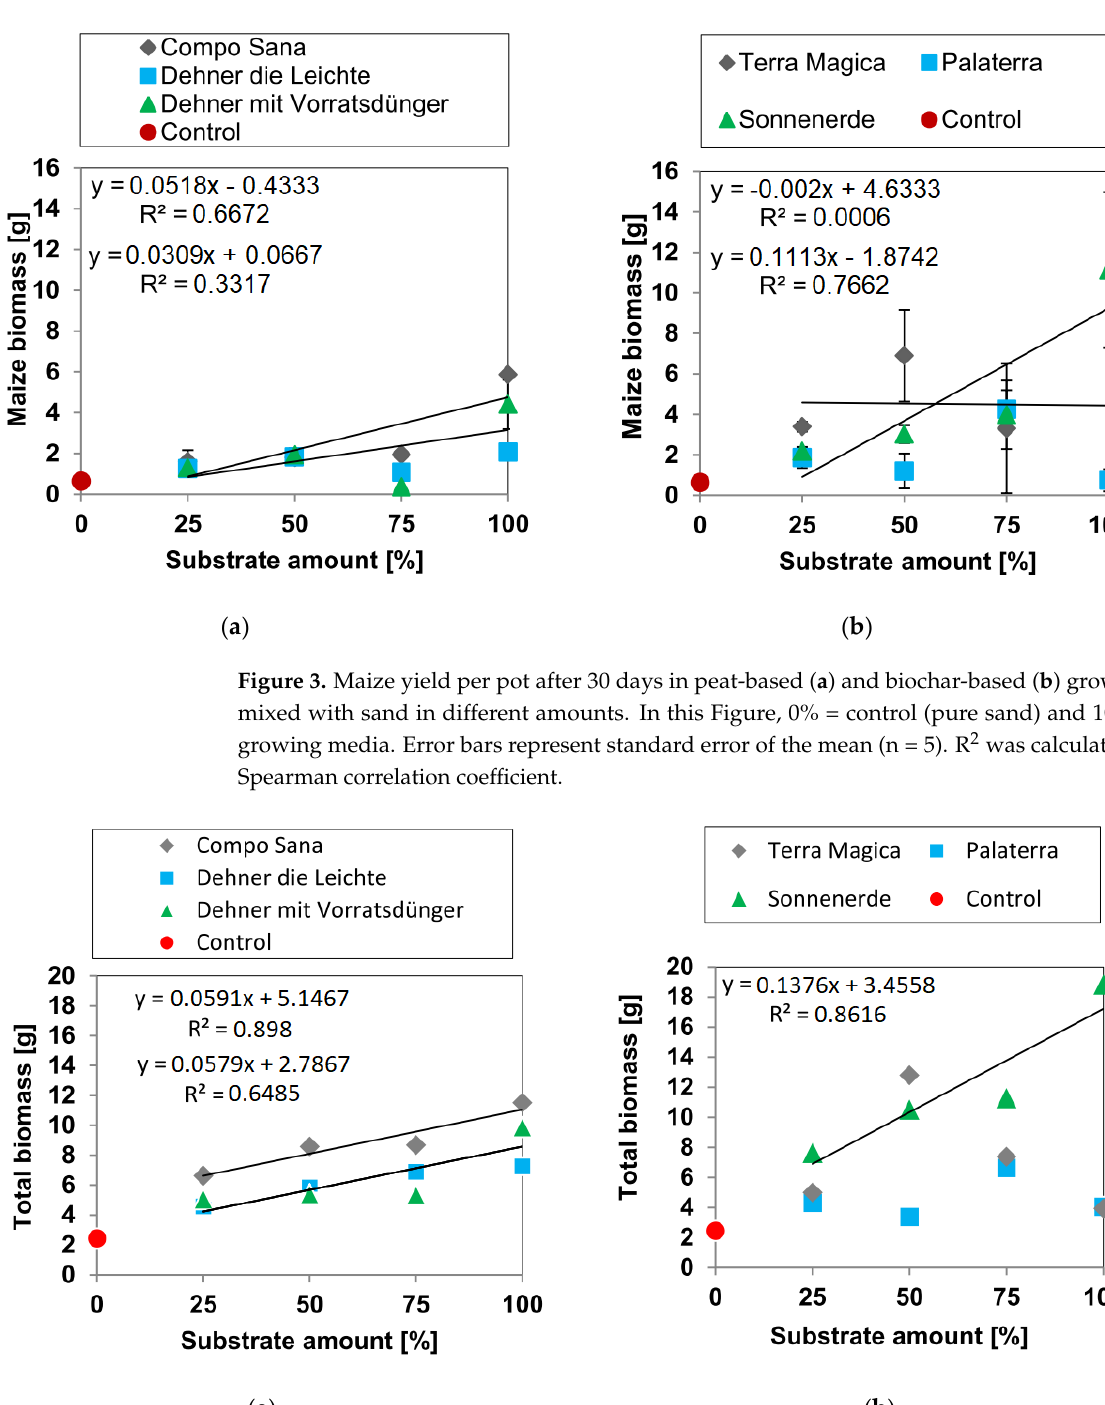
Figure 4. Total biomass yield (Barley plus wheat plus maize) per pot after 90 days in peat-based ( a ) and biochar-based ( b ) growing media mixed with sand in different amounts. In this Figure, 0% = control (pure sand) sand 100% = pure growing media. R 2 was calculated with the Spearman coeffi- cient.